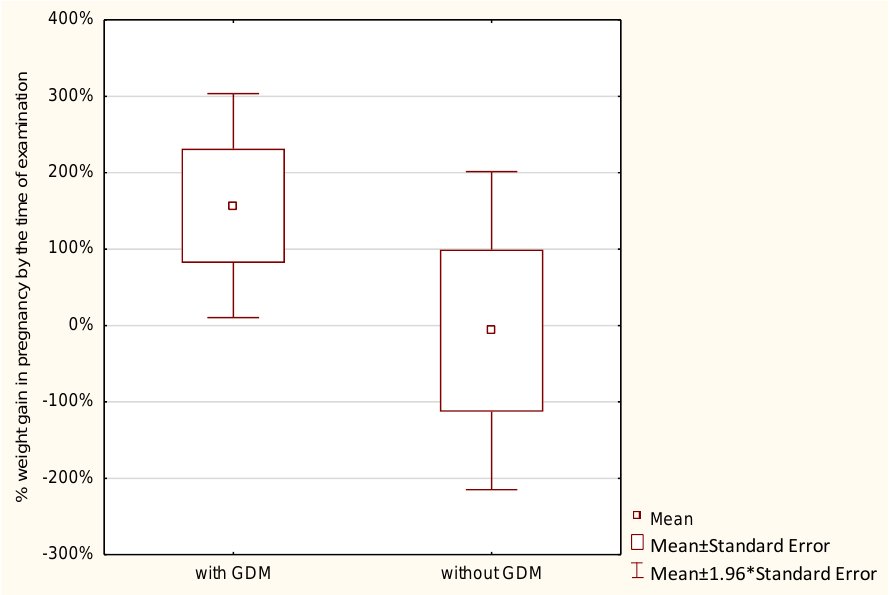
Figure 5. The percentage of GWG by the time of examination performed in pregnant women with a BMI of 25.0 – 29.9.